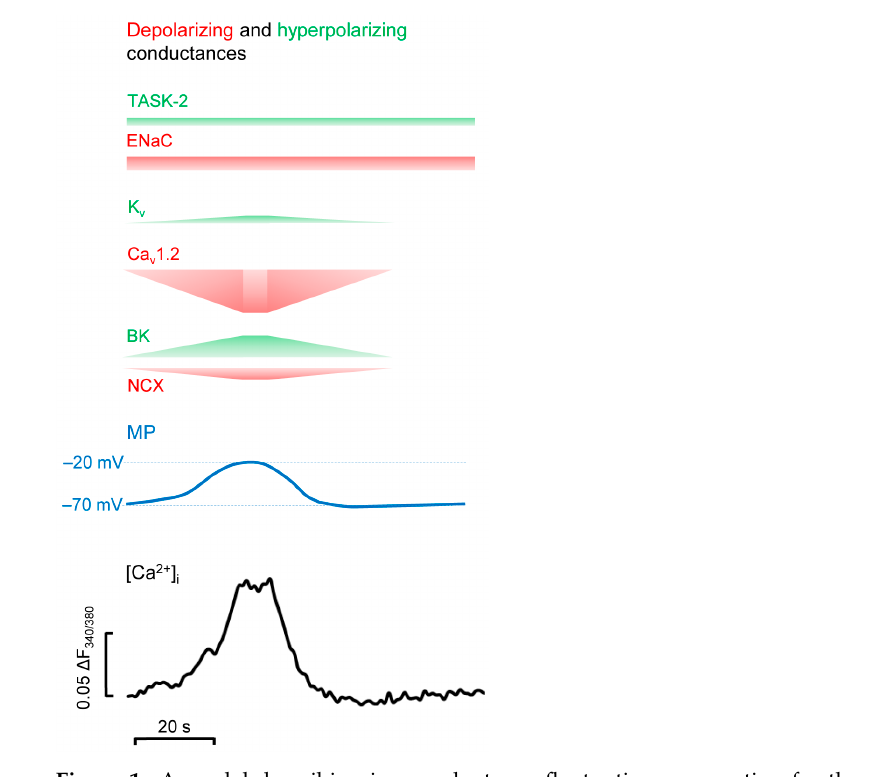
Figure 1. A model describing ion conductance fluctuations accounting for the oscillation of the membrane potential and intracellular Ca 2+ concentration in chondrogenic cells. An original record of a transient elevation of the intracellular Ca 2+ concentration ([Ca 2+ ]) in a single chondrogenic cell (as reported previously in [42] ) is shown in black. Simultaneous temporal change of the membrane potential (MP) and the relative magnitude of depolarising and hyperpolarising ionic conductances were estimated and are illustrated in blue, red, and green, respectively. This model involves BK channels, L ‐ type, voltage ‐ gated Ca 2+ channels (Ca v 1.2), the non ‐ voltage dependent epithelial Na + channel, and the Na + /Ca 2+ exchanger (NCX), which have all been shown to be essential for Ca 2+ oscillations [23,39,40,146,184,186,187]. In ad ‐ dition, the role of the “leak” K + channel TASK ‐ 2 and some voltage ‐ gated delayed rectifier K + channels (Kv1.1, 4.1, and 1.3) is also considered [4,50,145]. The baseline MP of chondro ‐ genic cells is quite depolarised (~ − 21 mV), suggesting that the TASK ‐ 2 background K + conductance and the delayed rectifier channel conductance are balanced by the constitu ‐ tively active Na + conductance of the ENaC. At this membrane potential, the Ca v 1.2 chan ‐ nels are open, which also contributes to the depolarised MP and mediates Ca 2+ influx. As the Ca v and BK channels are often clustered together, the local [Ca 2+ ] in the proximity of BK channels reaches values high enough to open them [188–191]. BK represents the pre ‐ dominant K + conductance in chondrogenic cells and is known to link Ca 2+ signalling to MP [23,192]. In doing so, the BK current will hyperpolarise the MP, which in turn deac ‐ tivates the Ca 2+ current. Elevated [Ca 2+ ] i is also the key to reverse the MP from its most ‐ hyperpolarised point, as it enhances NCX activity, which creates a depolarising current owing to its 3Na + /1Ca 2+ stoichiometry. While the NCX (in cooperation with the plasma membrane Ca 2+ pump (PMCA)) restores the [Ca 2+ ] I , the BK channel deactivates, and the inward cationic currents will prevail. This will cause the MP to spontaneously depolarise back to baseline, which will initiate the next membrane clock cycle again by activating the Ca 2+ current. Pharmacological inhibition of any component of this chain clamps the MP in a hyperpolarised or depolarised state and interrupts the cycle [23,40,184]. Additional in ‐ ward Ca 2+ currents, mediated by ionotropic purinergic receptors or transient receptor